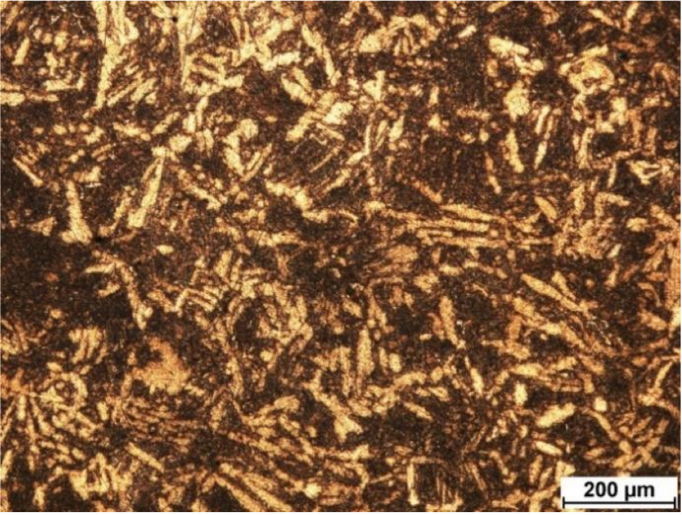
Figure 4. Microstructure of zirconium spark plasma sintered at 1400 ◦ C and cooling rate of 400 ◦